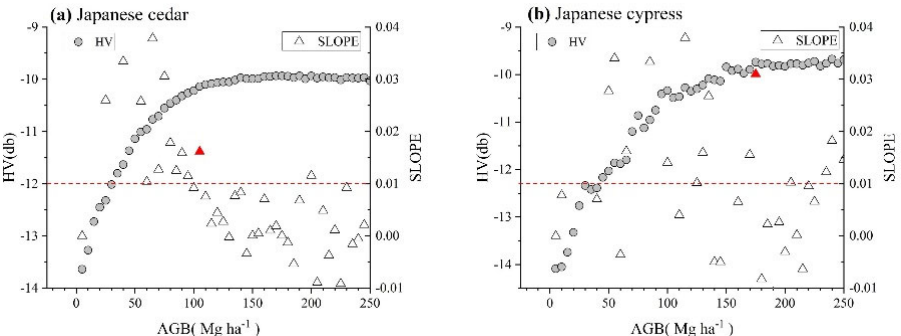
Figure 3. Determination of the aboveground biomass (AGB) saturation level as a function of the horizontal transmit–vertical channel (HV) backscatter coefficient and slope of every pair of neighbor plots. The saturation level is indicated by the red triangles.